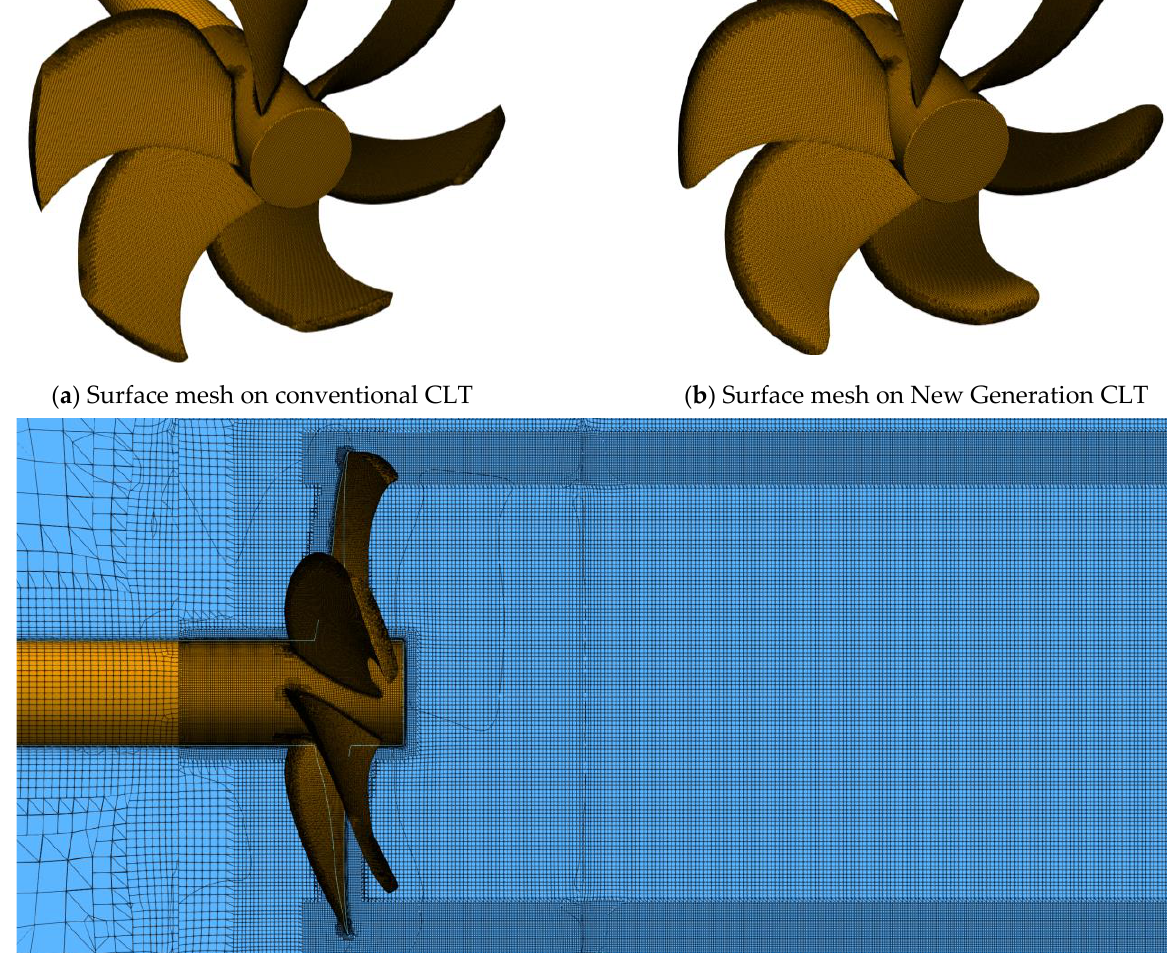
Figure 3. Surface mesh ( a , b ) and computational grid ( c ) for IDDES analyses.